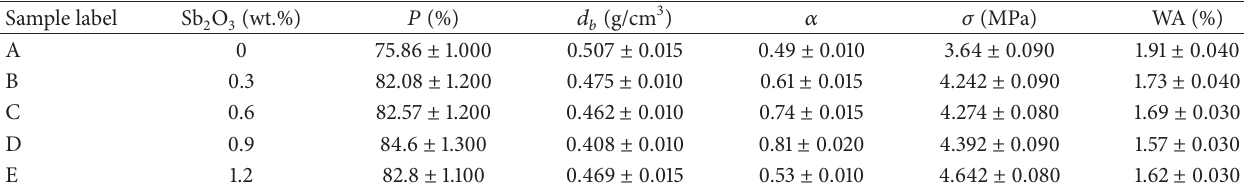
Table 1: Main physical properties of the foam glass samples sintered at 775 ∘ C for 30 min. Sample